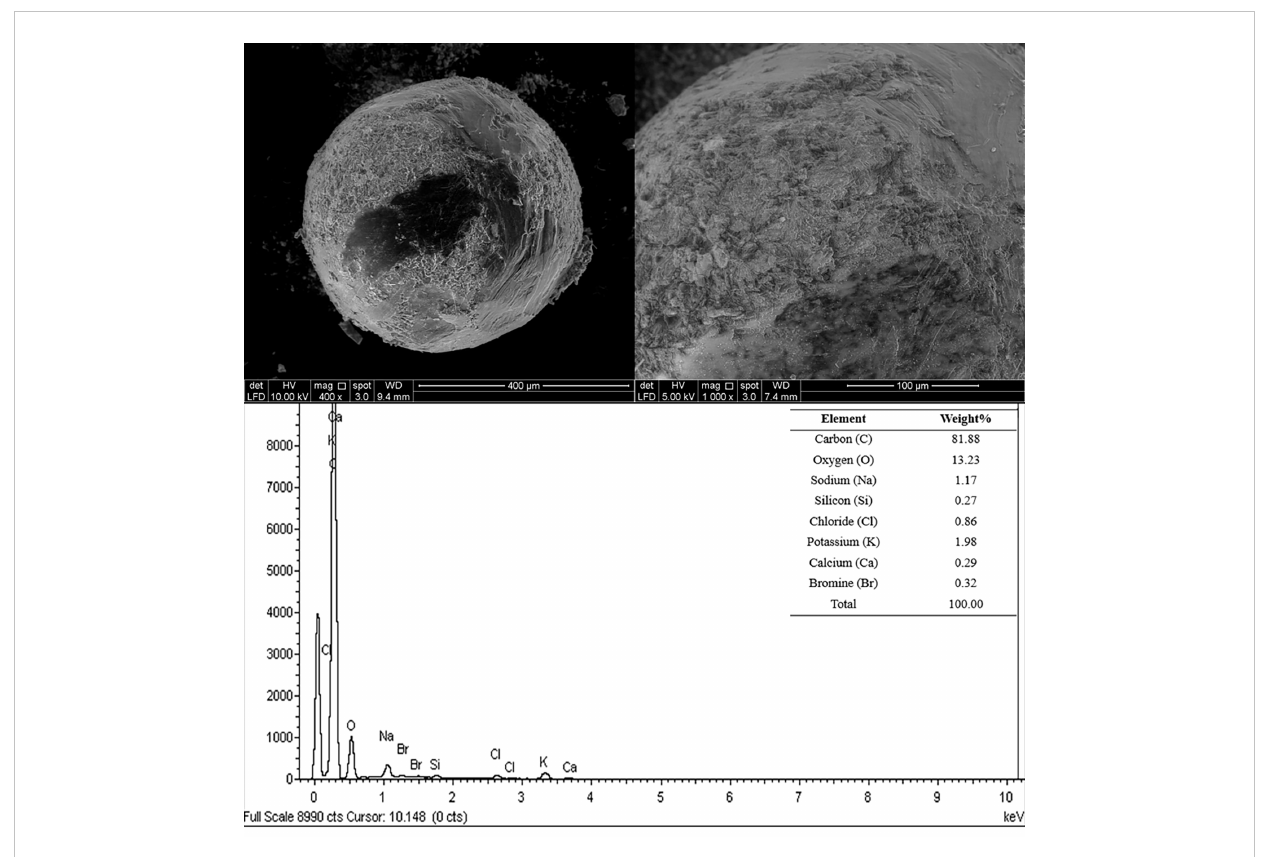
FIGURE 6 FESEM images of aged pellet and the corresponding EDX spectra recovered from the estuarine environment of